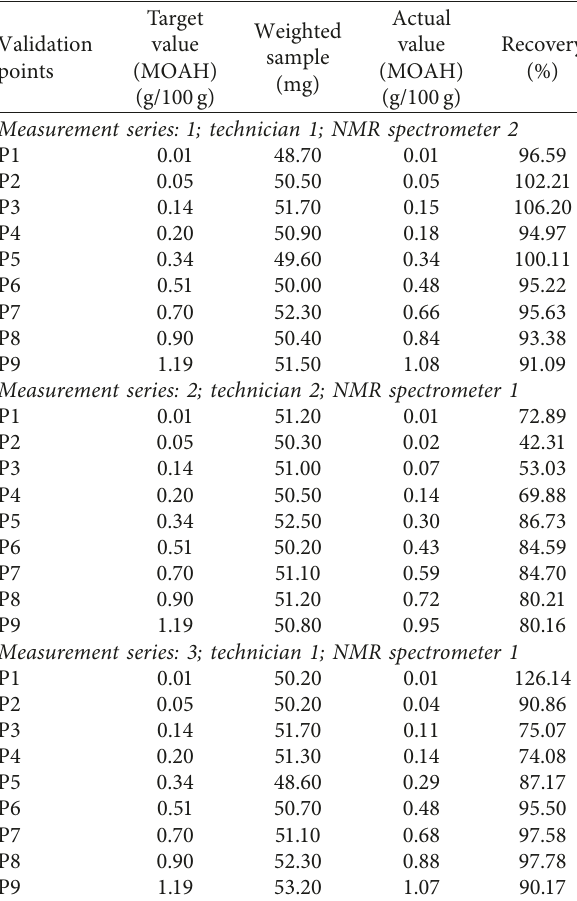
Table 6: Validation lip